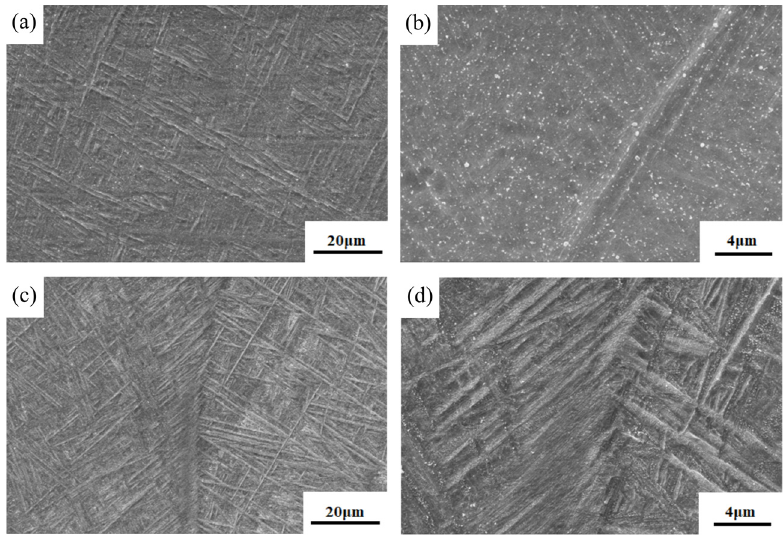
Figure 7. Comparison of the morphology of acicular α′ martensite between flux-cored wire and a cable wire welding joint: ( a , b ) flux-cored wire welding joint; ( c , d ) cable wire welding joint.